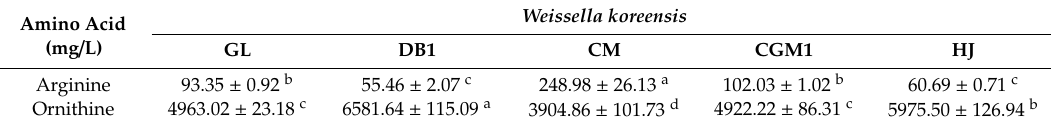
Table 1. Ornithine production from arginine by lactic acid bacteria (LAB) isolates. Amino Acid (mg /